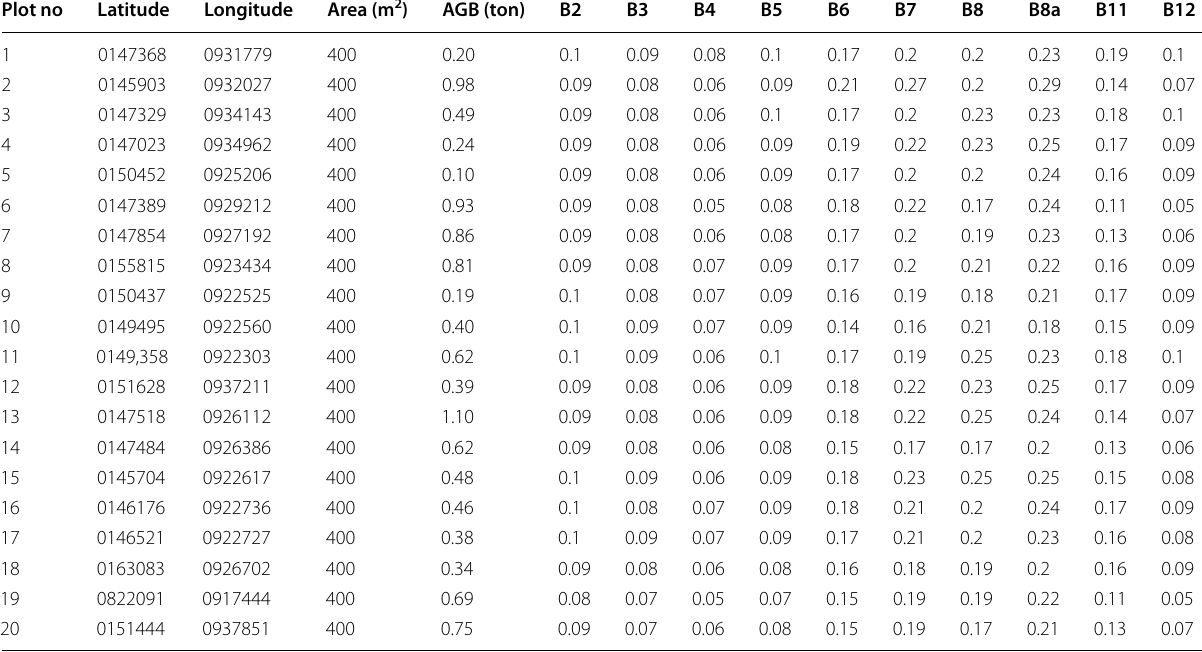
Table 3 Pixel values extracted from selected bands of Sentinel-2 image and AGB measured from plots Plot no